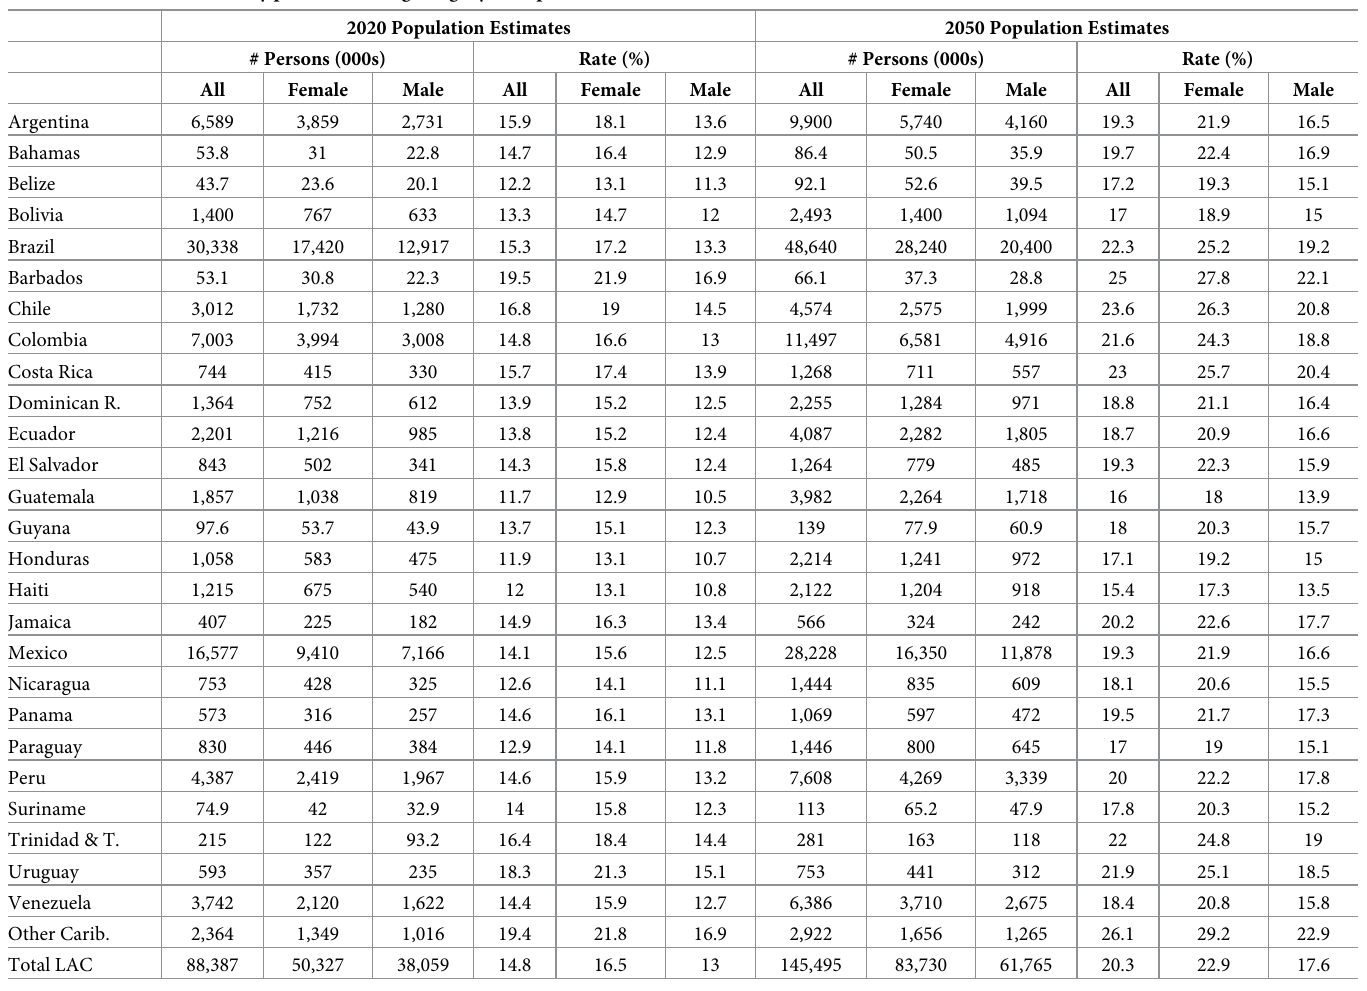
Table 6. Estimates for disability prevalence using Uruguay 2011 prevalence